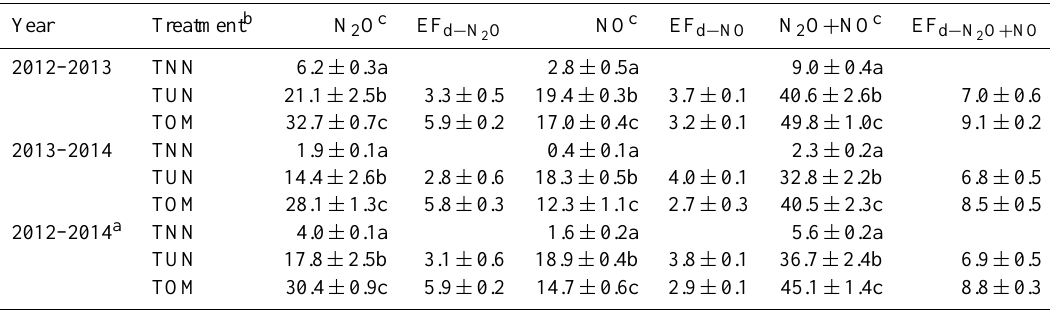
Data shown are means ± standard errors of four spatial replicates. a Mean values of the 2 investigated years. b TNN, no nitrogen fertilizer application; TUN, the common practice with urea application rate of 450kgNha − 1 yr − 1 ; and TOM, the alternative practice with organic fertilizer application rate of 450kgNha − 1 yr − 1 . c Different letters within the same column indicate significant differences among treatments in each year at P <0.05